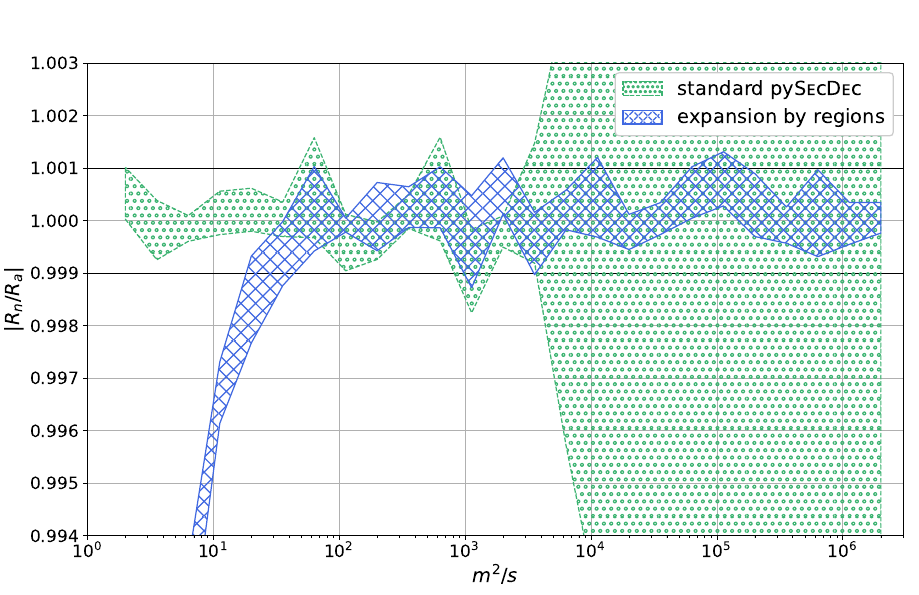
Figure 4: Scan over different orders of magnitude of r = m 2 / s for the two-loop triangle given in Fig 2. The modulus of the ratio between the numerical result and / R | , is plotted against r . The bands indicate the numerical the analytic result, | R n a uncertainties on the